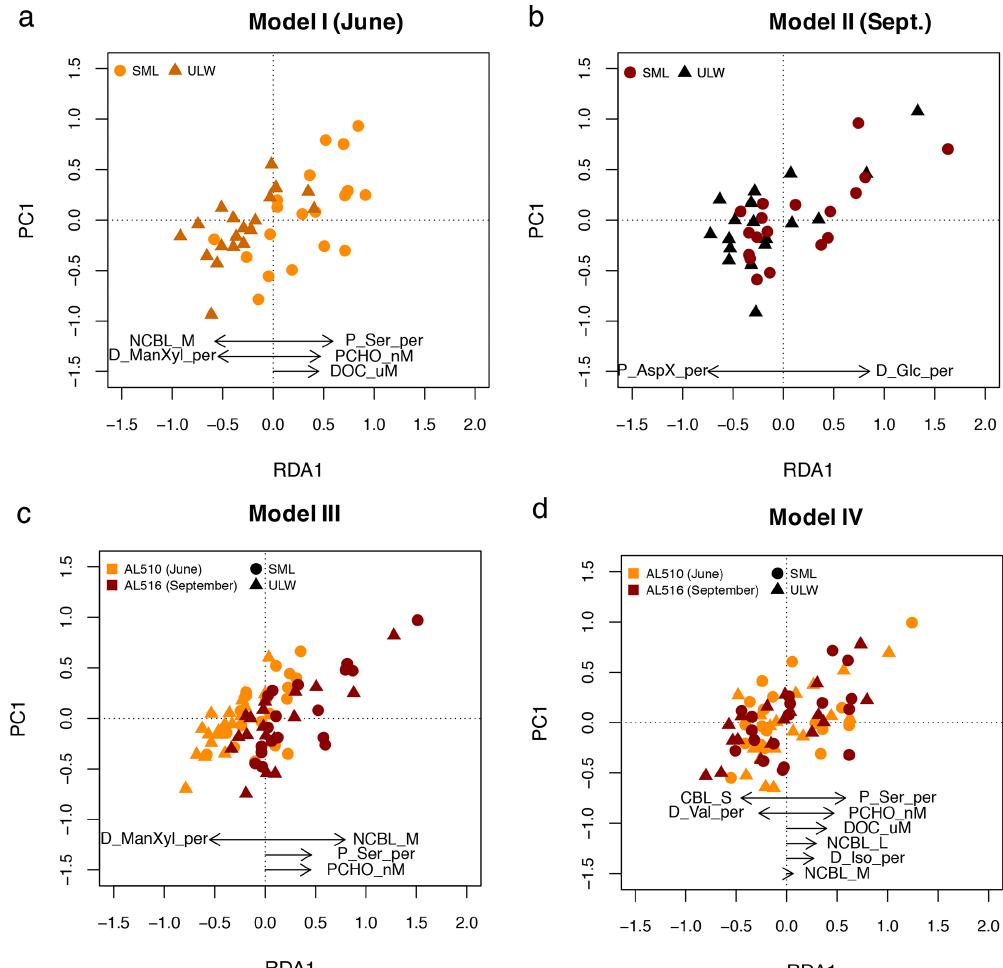
Figure 8. Linear regression models derived from redundancy analysis (RDA) reflecting which components represent surfactant dynamics best. (a) In June, surfactant concentration (as depicted in PC1) positively correlate to the fraction of particulate serine (P_Ser_per), particulate carbohydrates (PCHO), and dissolved organic carbon (DOC). (b) In September, surfactants correlate positively to the fraction of dissolved glucose (D_Glc_per). (c) When the effect of seasons is included in the statistical model, nano-NCBL cell abundance (phytoplankton cells > 2µm containing the phytopigment chlorophyll a ) correlates positively in concert with P_Ser_per and PCHO. (d) When the effect of seasons is excluded, P_Ser_per, PCHO, and DOC represent surfactant dynamics best. Other abbreviations: sea surface microlayer (SML) and the underlying water (ULW), dissolved mannose and xylose (D_ManXyl_per), isoleucine (D_Iso_per), and valine